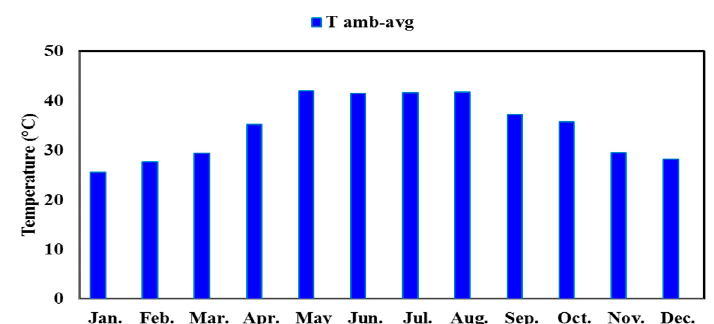
Figure 1. Average ambient temperature of Al-Ain, UAE for a typical day of each month.